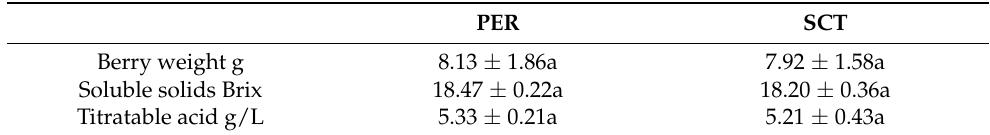
Table 2. The effects of PER (pergola) and SCT (single-curtain training system) on berry weight, soluble solids, and titratable acid content in 2021.